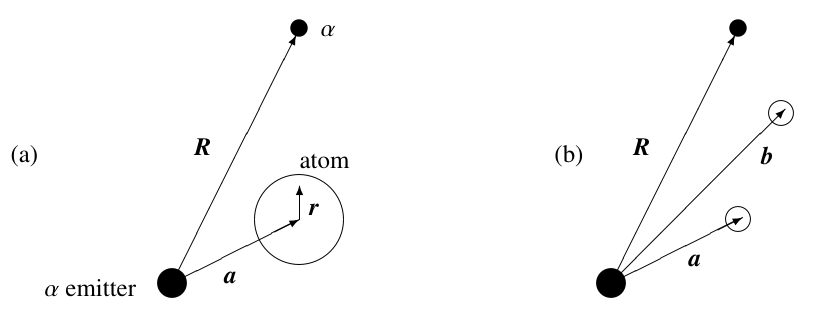
Figure 1. Theoretical systems used to describe the emission of an α particle by an α emitter in a cloud chamber. Nuclei are represented as filled circles; cloud-chamber atoms are represented as empty circles. Only (a) the atom (b) the two atoms nearest to the α emitter are